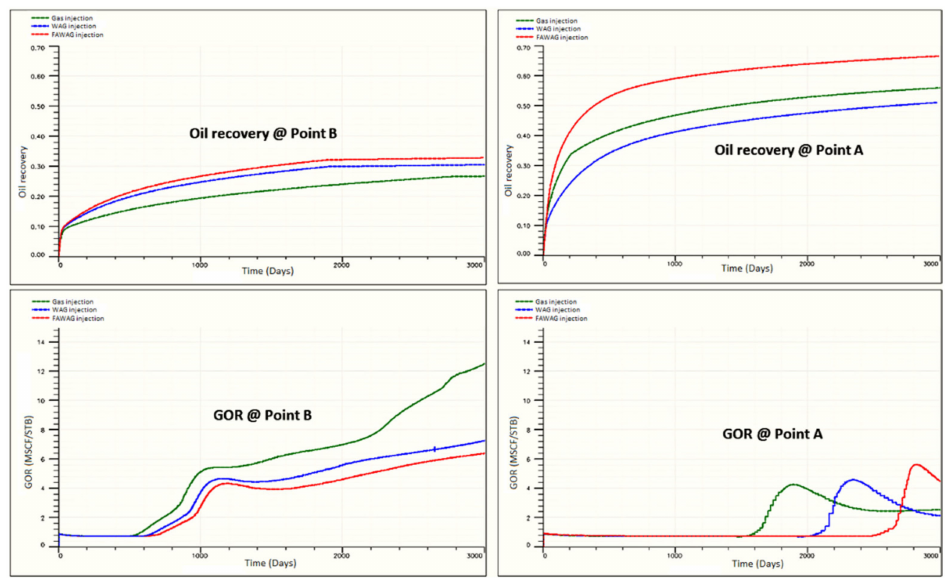
Figure 13. Oil recovery and GOR comparison for selected zone A and